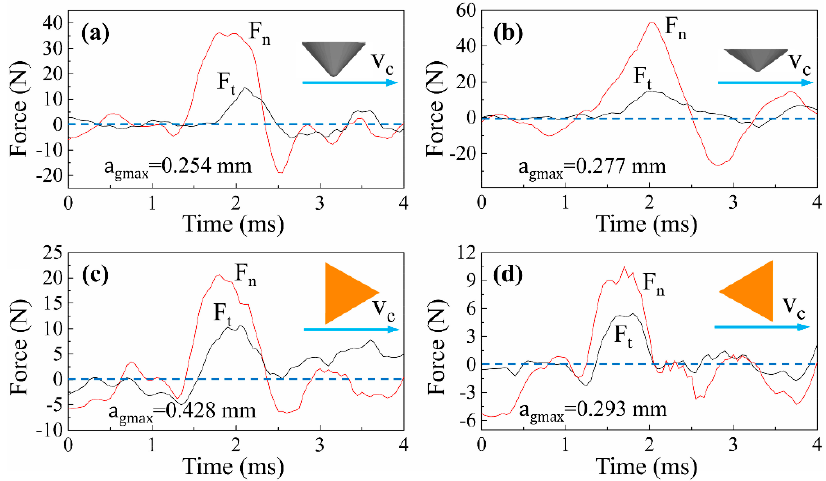
Figure 13. Typical cutting force curve of the scratches ( λ = 90 ◦ ) cut by: ( a ) spherical cone tool with 2 α = 84 ◦ , ( b ) spherical cone tool with 2 α = 108 ◦ , ( c ) triangular pyramid tool with one main cutting edge and two side cutting edges, and ( d ) triangular pyramid tool with two main cutting edges.